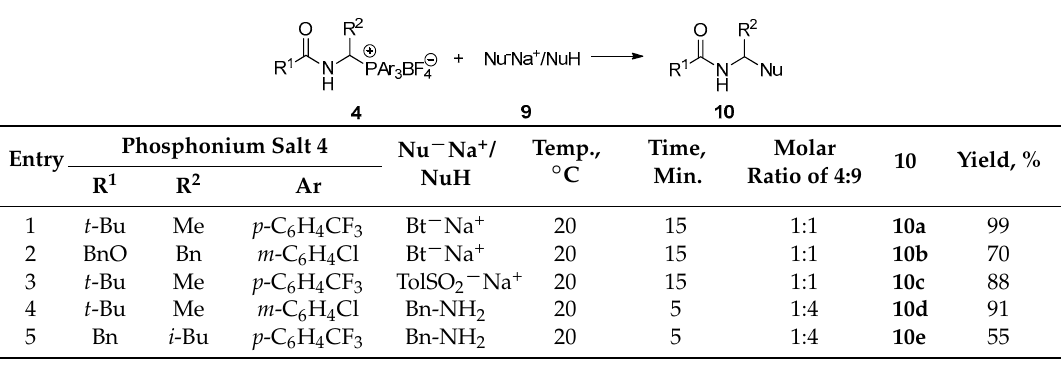
Table 3. Conditions and yields for α -amidoalkylation of selected heteronucleophiles by 1-( N -acylamino) alkyltriarylphosphonium salts 4 .